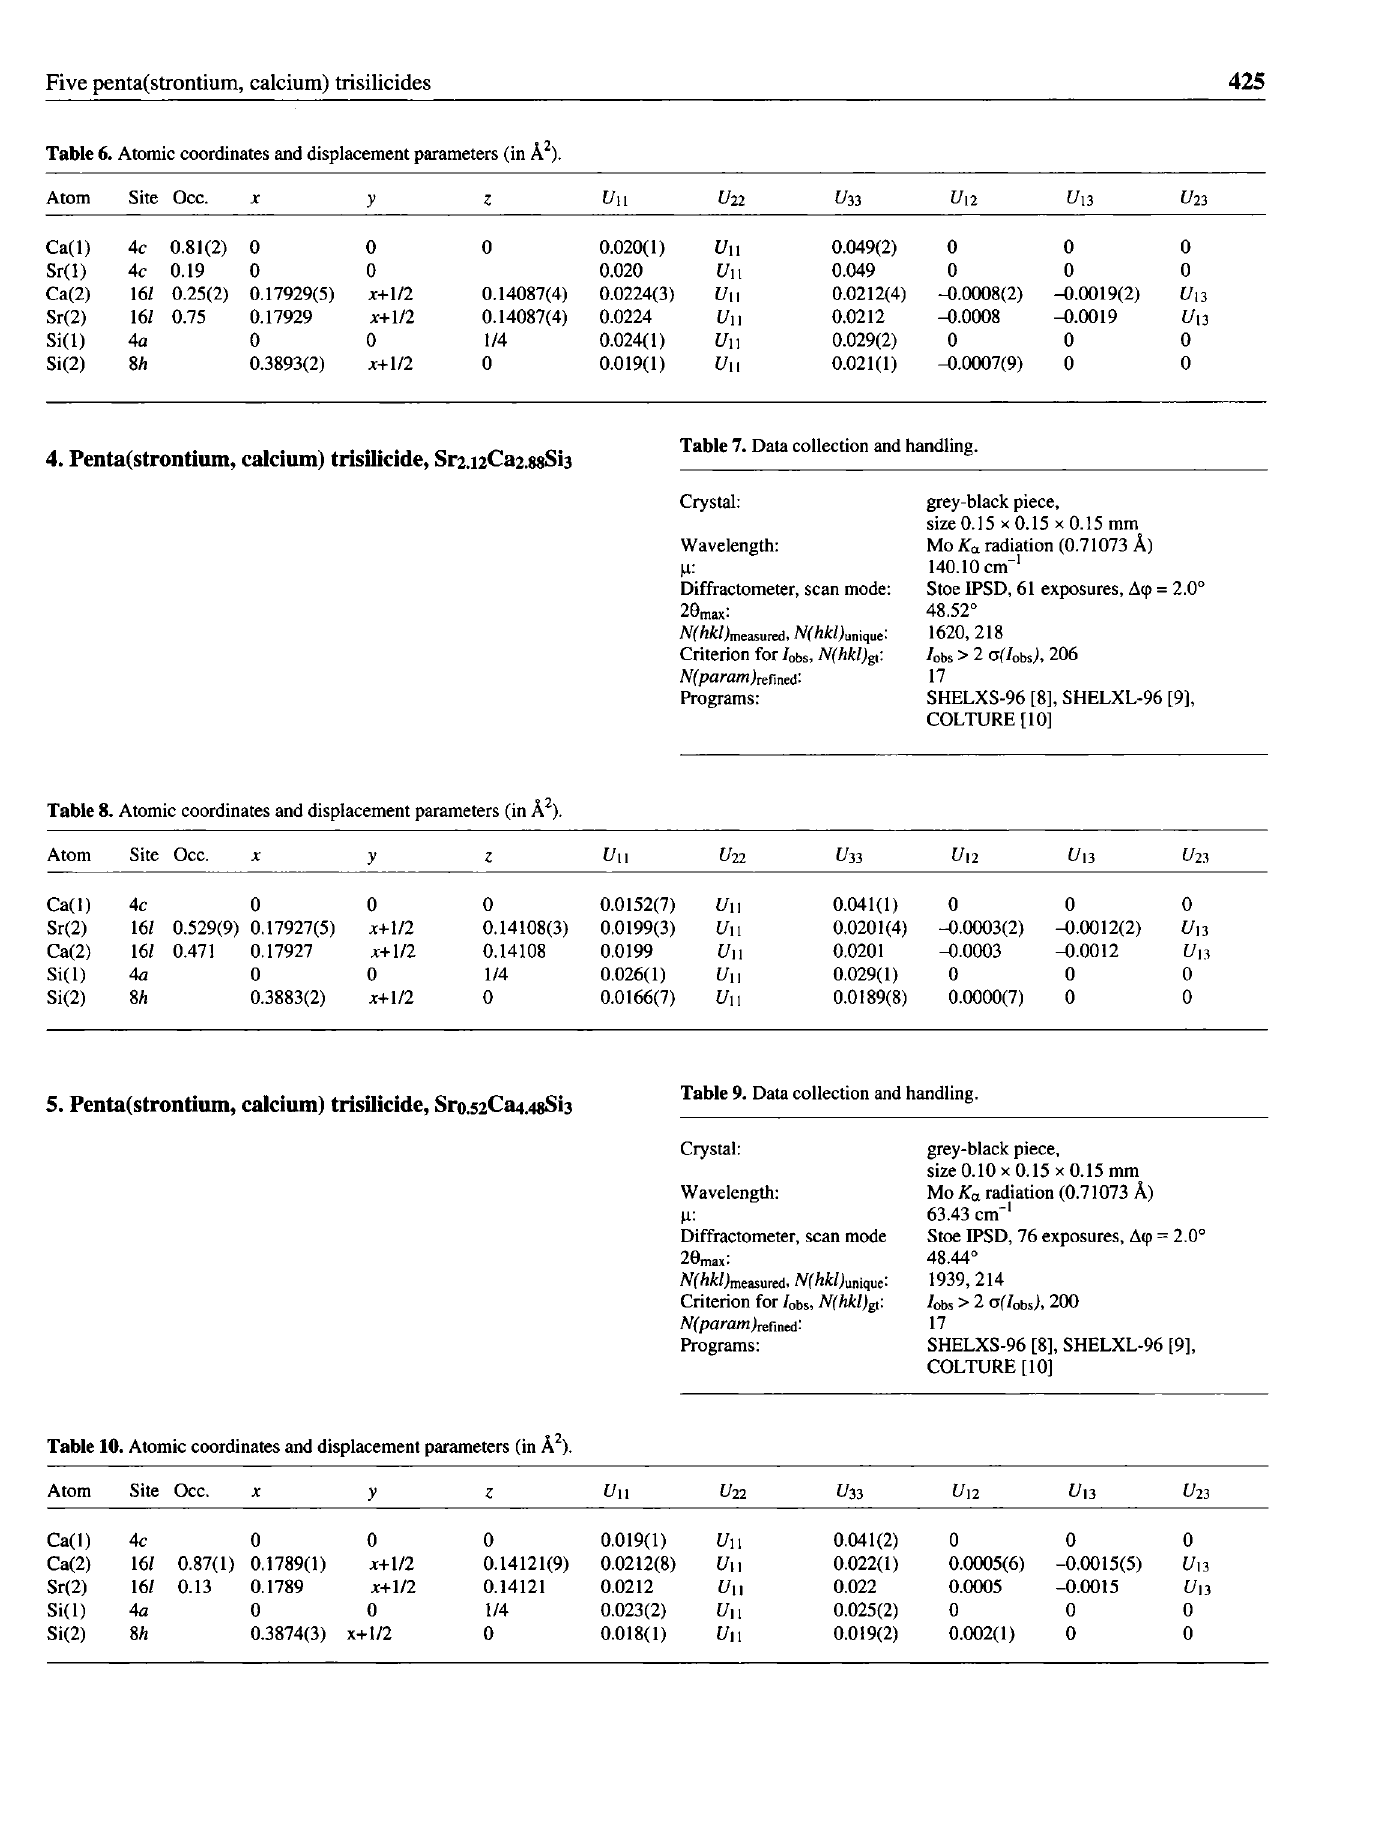
Table 10. Atomic coordinates and displacement parameters (in Ä 2 ). Atom Site